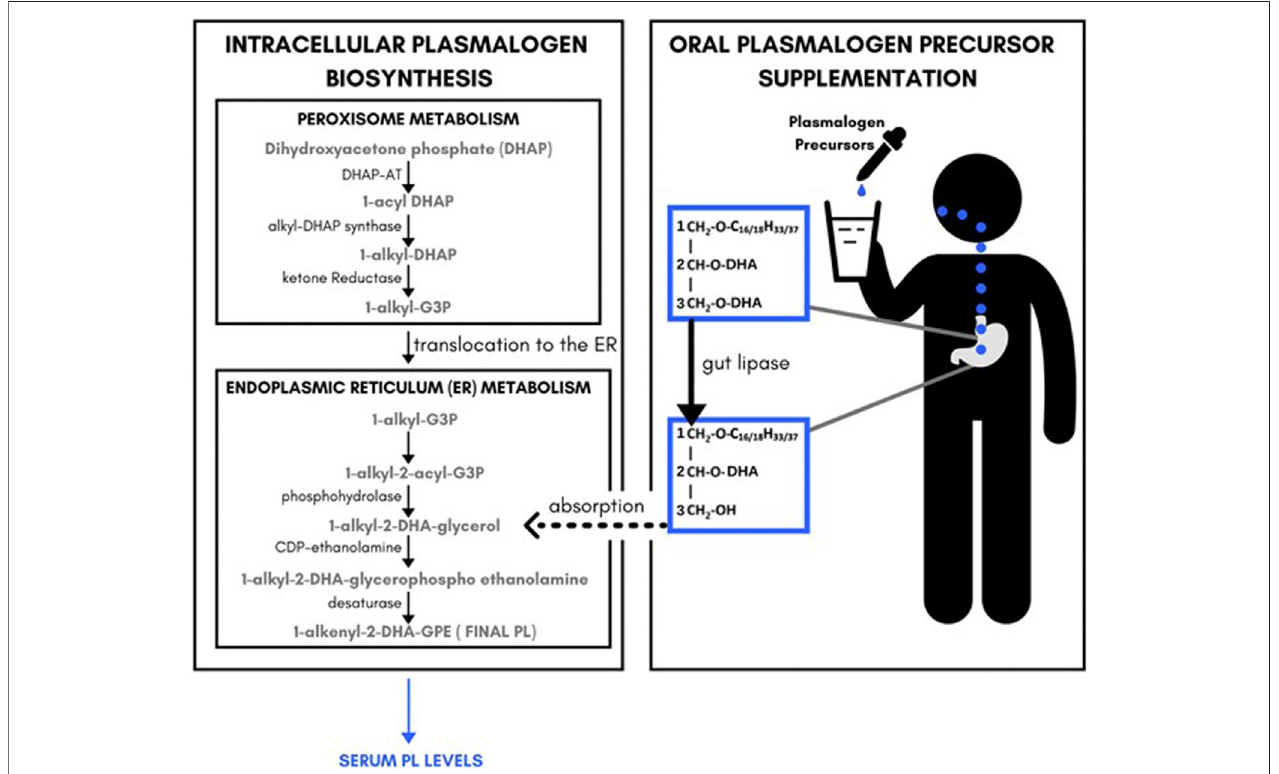
FIGURE 3 | Relationship between endogenous plasmalogeon biosynthesis pathways, plasmalogeon precursor supplement administration and serum plasmalogeon levels.